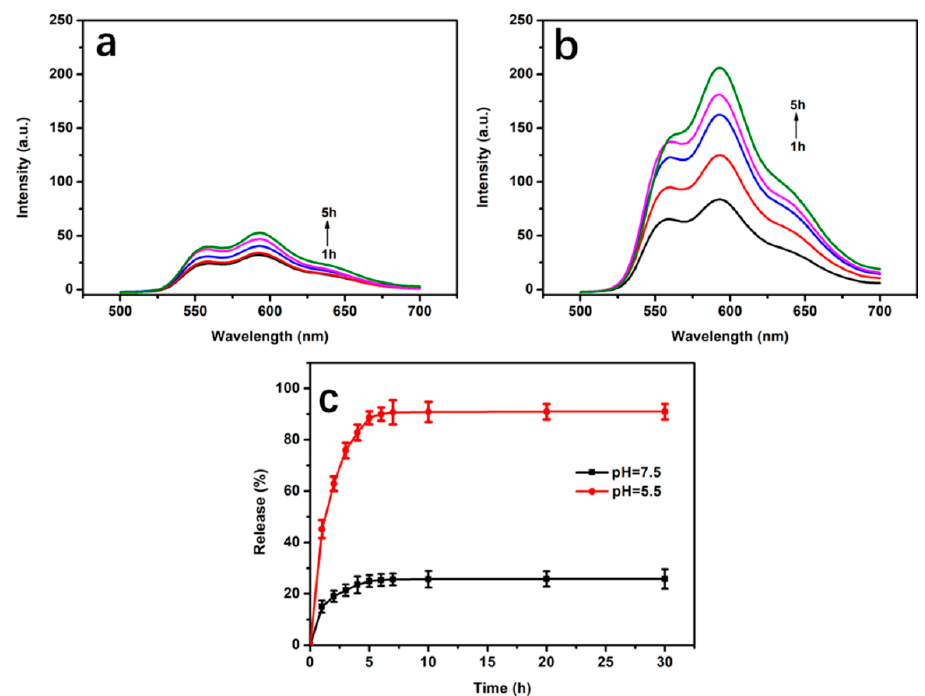
Figure 6. Time-dependent fluorescence spectra of drug release after incubating ZnO@PC 400 D 400 -DOX at ( a ) pH = 7.5 and ( b ) pH = 5.5 at different times (1 − 5 h); ( c ) the drug release profile of the ZnO@PC 400 D 400 -DOX on different pH environments.